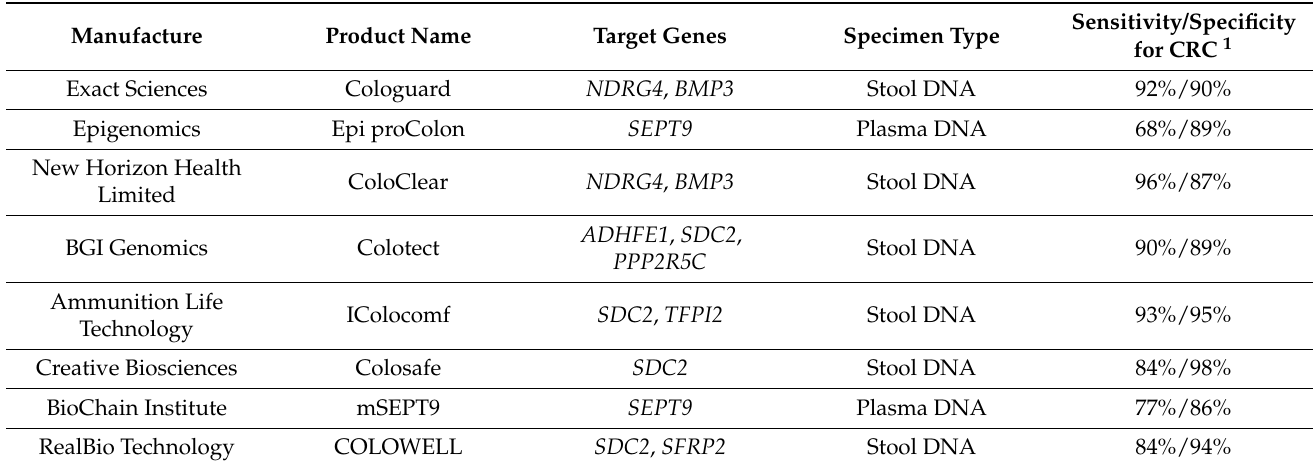
Table 1. Commercial methylation kits for colorectal cancer